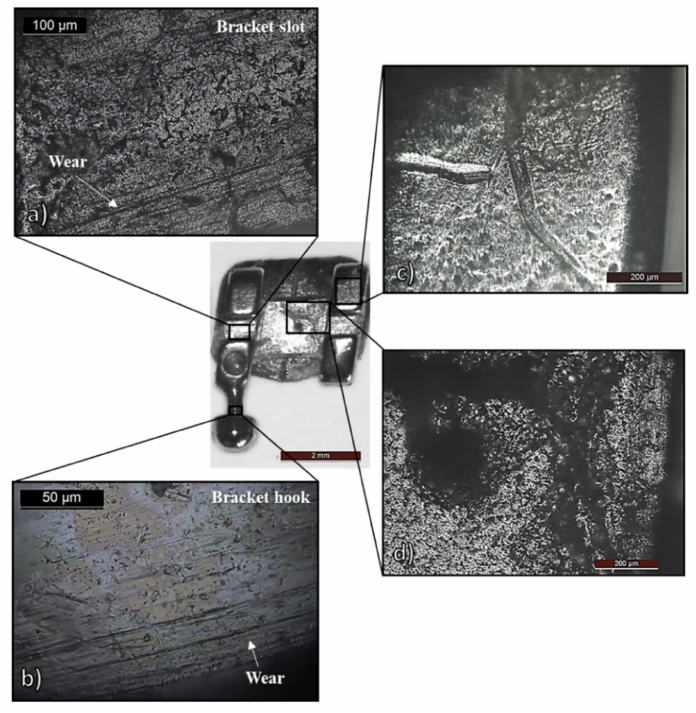
Figure 4. SS bracket after two years of intraoral use: optical microscopy (OM) micrographs show- ing ( a , b ) fretting corrosion; ( c ) deformation tracks by archwires manipulation; ( d ) biofilm-covered pitting